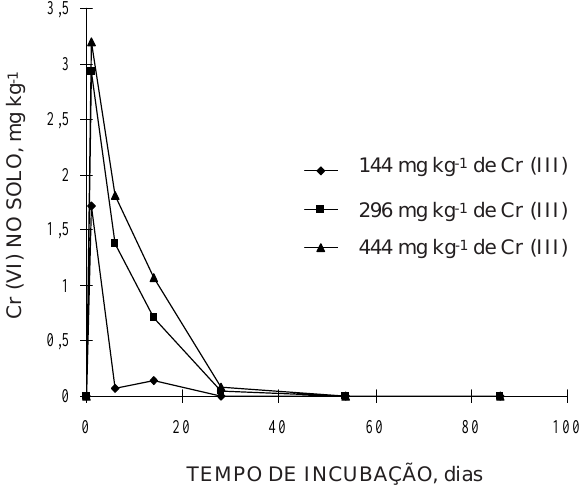
Figura 1. Evolução do Cr 6+ em Latossolo Roxo, unidade Ribeirão Preto, considerando o tempo de incubação e a adição de CrCl 3